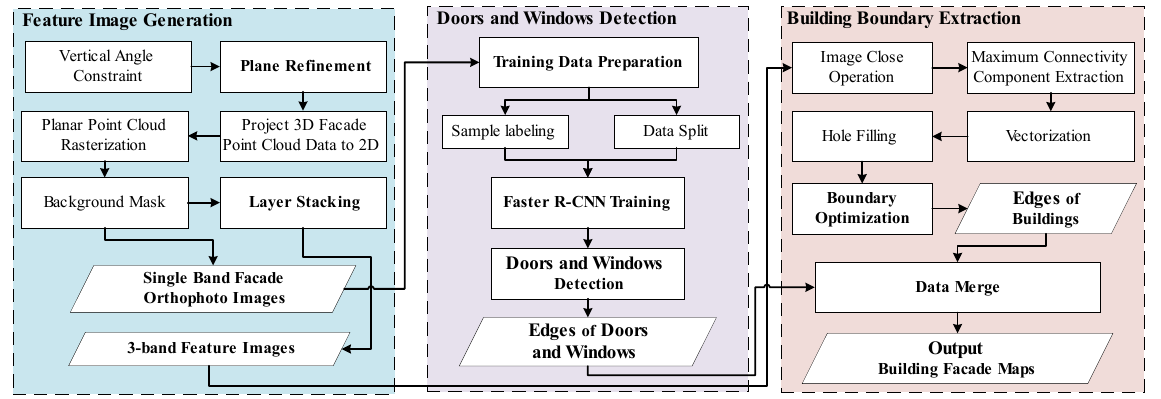
Figure 6. Processes of building facade map extraction.